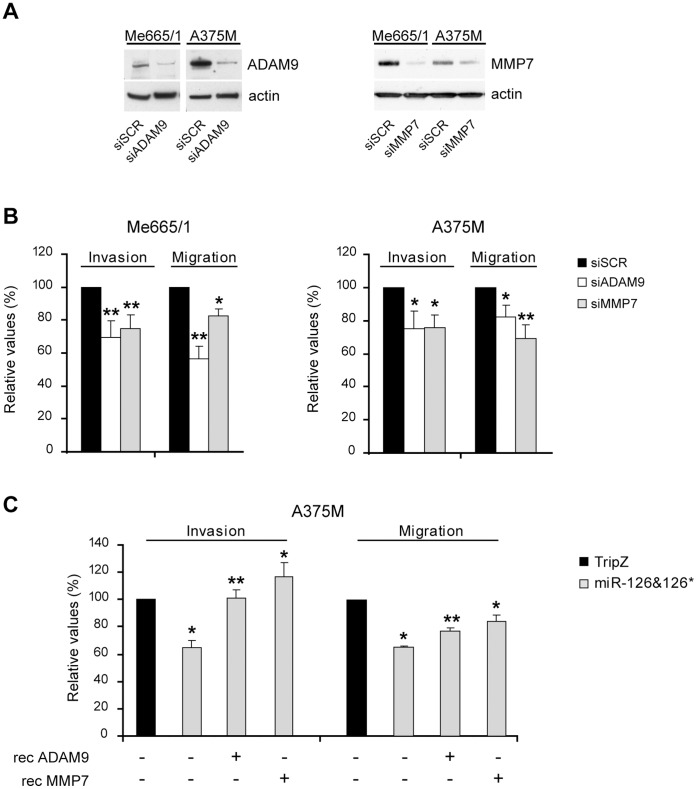
ADAM9 and MMP7 functional roles. A)Western blot analyses showing the effectiveness of stable si-ADAM9, si-MMP7 and scrambled control (SCR) transduction. B) Invasion and migration assays in si-ADAM9- or si-MMP7-infected melanoma cell lines compared with scrambled control. C) Invasion (left) and migration (right) in presence of either ADAM9 or MMP7 recombinant proteins in miR-126&126*-transduced A375M cell lines compared with control cells. Columns, mean±SD of a minimum of two independent experiments; **P<0.001; *P<0.05.